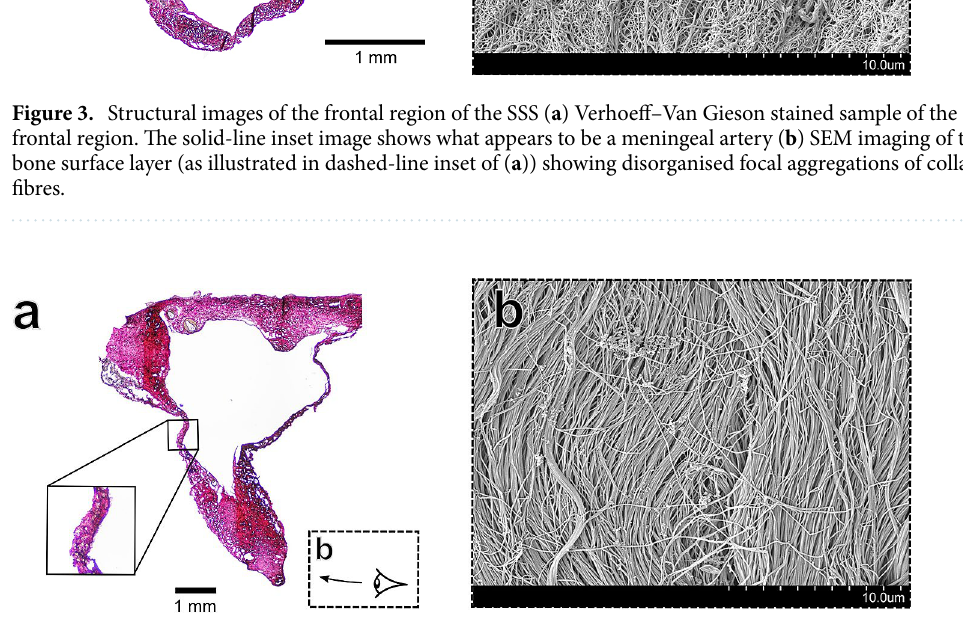
Figure 4. Structural images of the parietal region of the SSS ( a ) Verhoeff–Van Gieson stained sample. The solid- line inset image shows the thin, collagenic wall of the sinus with a thin endothelial layer on the lumen wall ( b ) The arachnoid surface of the sinus (as illustrated in dashed-line inset of ( a )) demonstrating collagenic alignment along the longitudinal direction of the sinus.